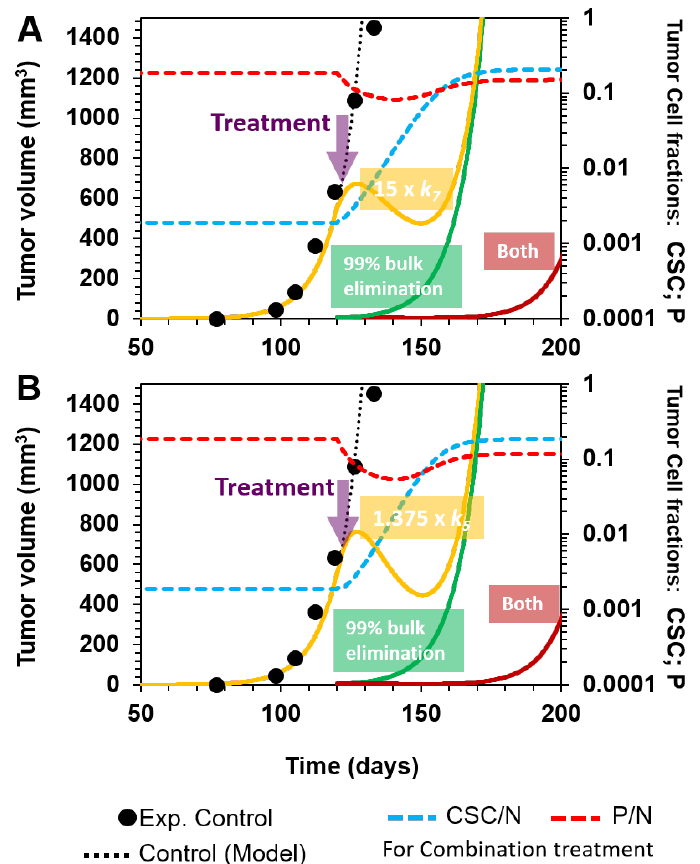
Figure 5. Targeting of intermediate P cells. ( A ) Selective elimination of P cells by increasing k 7 15-fold at day 120 (yellow line). This e ff ect is comparable to the nonselective eradication of 99% of total tumor cells (green line). However, when both treatments are performed simultaneously, there is an increment of time before tumor relapse (dark red line). All treatments were started at day 120 (purple arrow). ( B ) Increasing P cell di ff erentiation ( Φ 5 / 4 is increased from 0.8 to 1.1, which is equivalent to increasing 37.5% k 5 , at day 120; yellow line), eliminating 99% of total cells (green line), and the combination of both treatments (dark red line) have similar e ff ects, as depicted in ( A ). The CSC fraction (dashed blue lines) and P cell fraction (dashed red lines) are shown for combination treatments in ( A , B ).